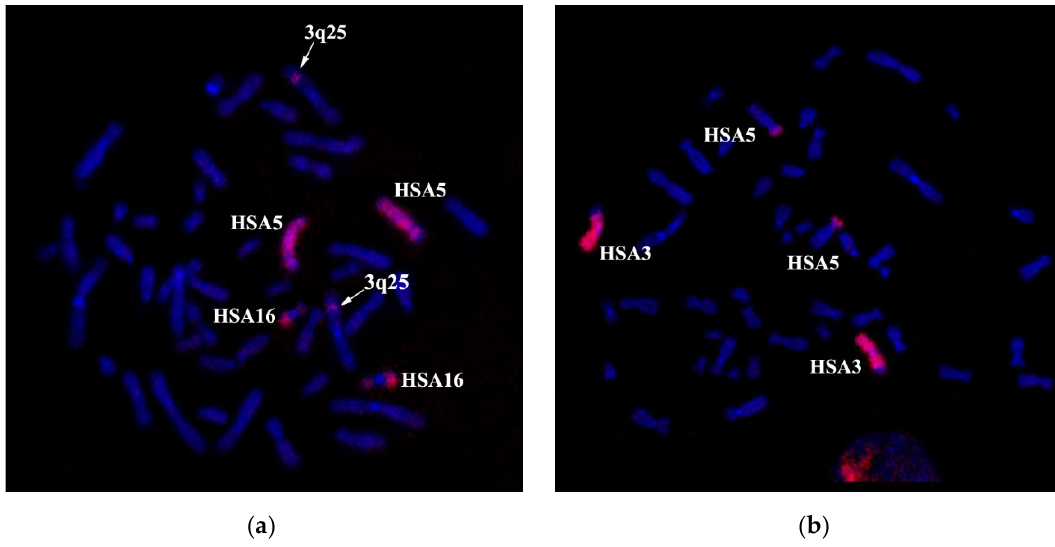
Figure 7. CISS-hybridization of microdissection DNA probes prepared from single abnormal chromosomes: PCPder(5) ( a ) and PCPder(3) ( b ) DNA probes on metaphase chromosomes of a healthy donor. Chromosomes 3, 5, and 16 with a specific red signal are indicated. Chromatin DAPI staining is in blue.